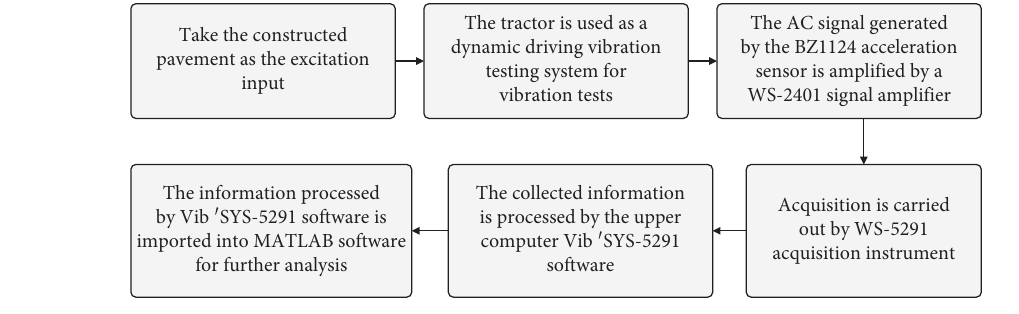
Figure 3: Vibration test flow.